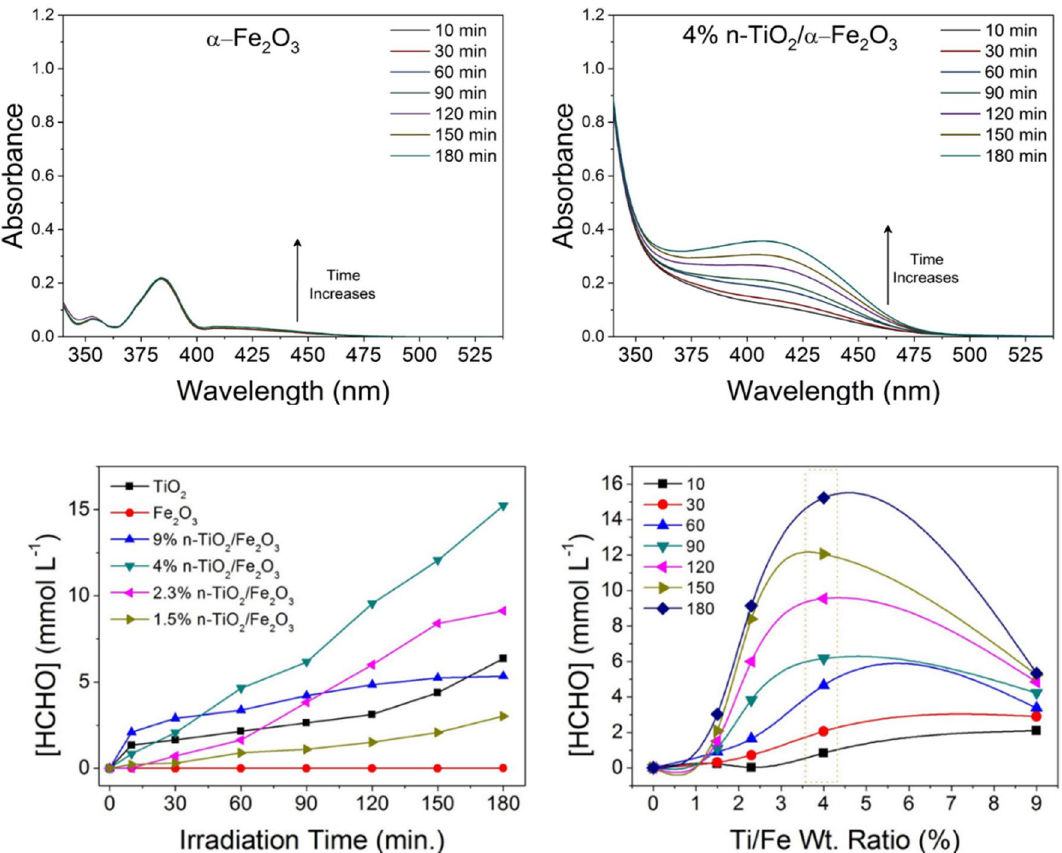
Figure 10. ( Top ) Temporal UV–Visible absorption spectra showing the progressive oxidation of methanol to formaldehyde under visible-light illumination up to 3 h under continuous stirring and exposure to the light stream. ( Bottom-a ) A plot comparing the quantity of formaldehyde generated as a function of irradiation time for TiO 2 , α-Fe 2 O 3, 1.5% n-TiO 2 @α-Fe 2 O 3, 2.3% n-TiO 2 @α-Fe 2 O 3, 4% n-TiO 2 @α-Fe 2 O 3, and 4% n-TiO 2 @α-Fe 2 O 3 showing the improved HCHO formation rates in case of n-TiO 2 . ( Bottom-b ) Plot showing the effect of the composite ratio on the quantity of HCHO formed after visible-light